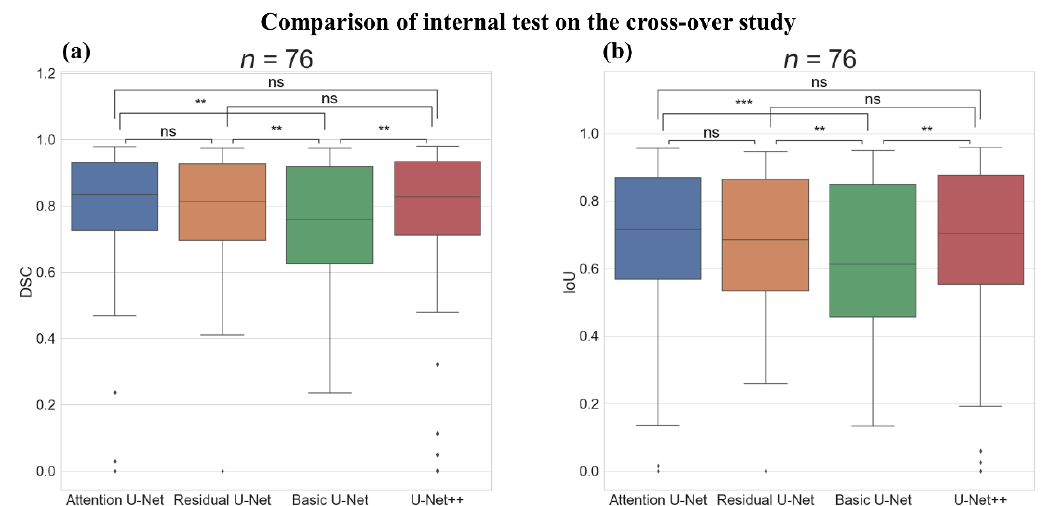
Figure 8. Comparison of the internal test on the cross-over study with Boxplot representation and